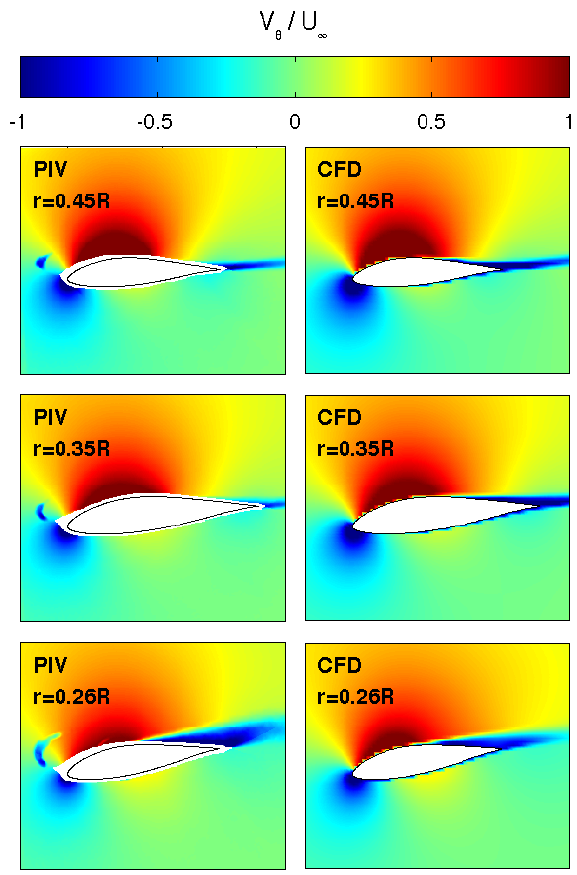
Figure 5. Experimental and numerical results of the azimuthal ve- locity component at different blade spanwise